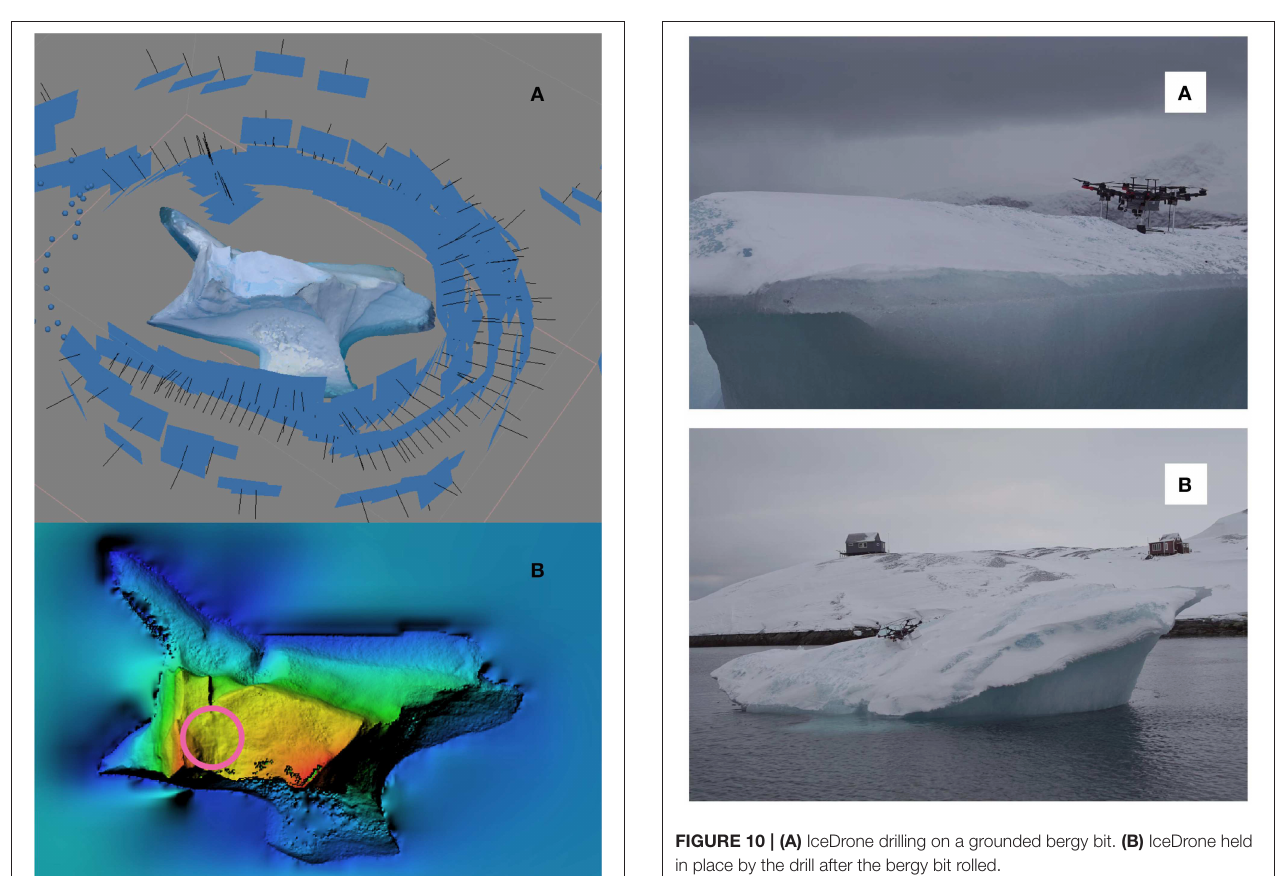
pan commands from the controller. Vibration dampeners should be installed on the gimbal mount to eliminate this